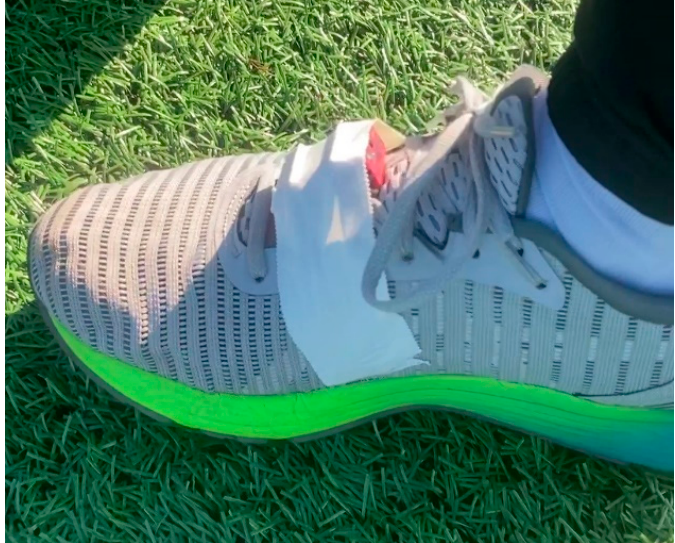
Figure 1. Attachment of the IMU on the instep.